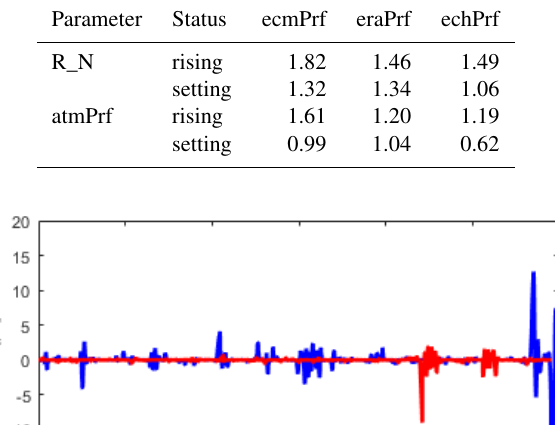
Table 5. The summary of the mean relative refractivity deviation between COSMIC observations and ECMWF analyses (%).